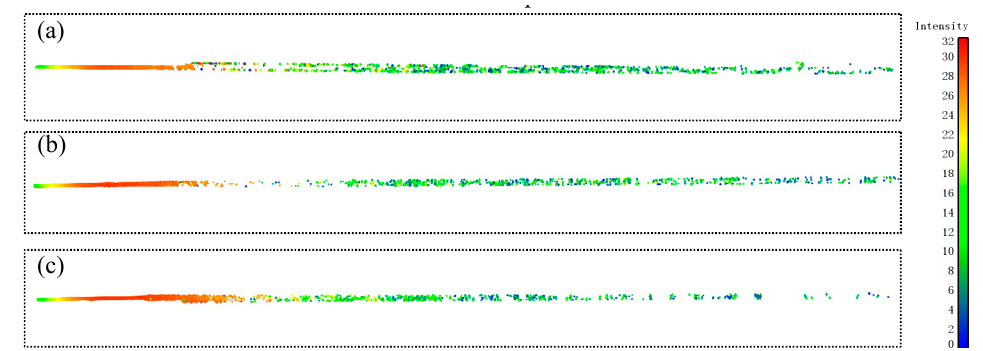
Figure 3. Point cloud for the narrow (about 0.5 m) sampled slices of the cement road with distances from 5 m to 500 m colored by the original intensity data. ( a ) Site 1 (31°46 ′ 03 ″ N, 121°11 ′ 01 ″ E). ( b ) Site 2 (31°46 ′ 13 ″ N, 121°11 ′ 15 ″ E). ( c ) Site 3 (31°49 ′ 24 ″ N, 121°12 ′ 43 ″ E). The number of points is 103,970, 116,242, and 135,561 for Sites 1, 2, and 3, respectively.